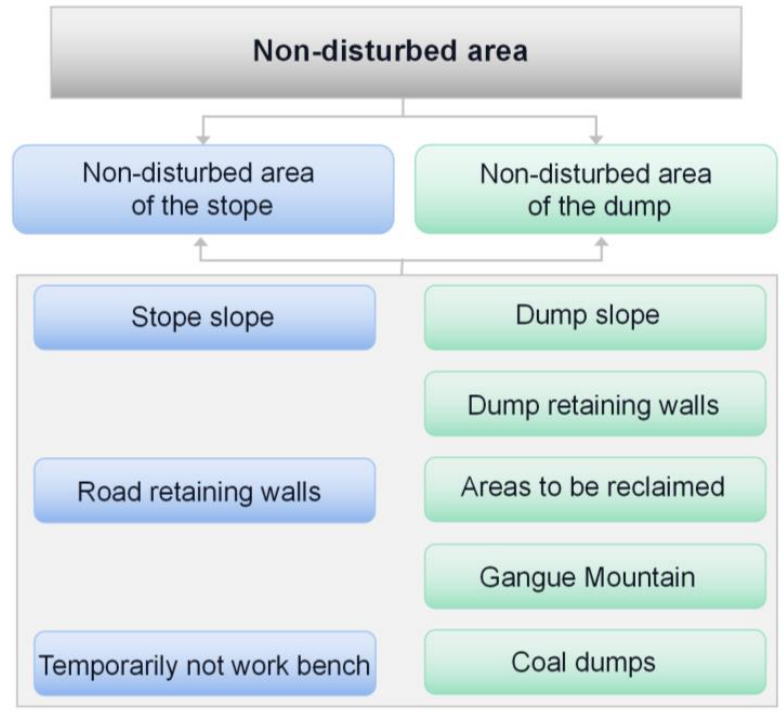
Figure 2. Non-disturbance zone of the open-pit coal mine.